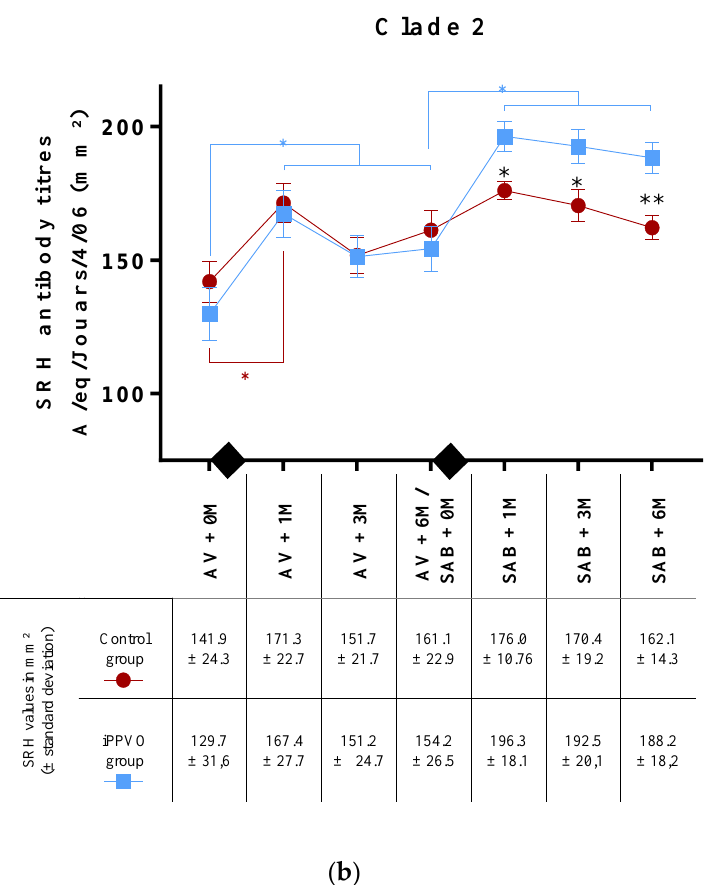
Figure 2. Mean H3N8 single radial haemolysis (SRH) antibody response measured before and after booster vaccination. The values correspond to sera isolated from blood samples that were collected in the control and iPPVO groups before the annual vaccination (AV), 1 and 3 months after the AV and before the semi-annual boost (SAB), and 1, 3 months and 6 months after the SAB. The red circles correspond to the mean SRH values in the control group ( n = 10), and the blue squares correspond to the mean SRH values in the iPPVO group ( n = 10) for ( a ) A/equine/Paris/1/2018 strain clade 1 strain and ( b ) A/equine/Jouars/4/06 EIV clade 2 strain. The diamonds represent the time of the AV injection and the 6 months SAB injections with or without iPPVO. Error bars represent standard error of the mean. Black stars correspond to a significant increase in the haemolysis area for the iPPVO group compared to the control group (two-factor ANOVA test; * and ** for p < 0.05 and p < 0.005, respectively). A red star represents the significant increase in the haemolysis area for the control group over time, and the blue stars represent the significant increase in the haemolysis area for the iPPVO group over time.